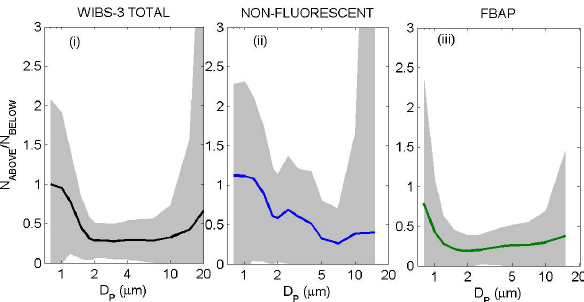
Fig. 13. Above canopy:understorey number concentration ratio as a function of particle size for (i) N WIBS , (ii) N NON and (iii) N FBAP , with ± 1standard deviation highlighted in